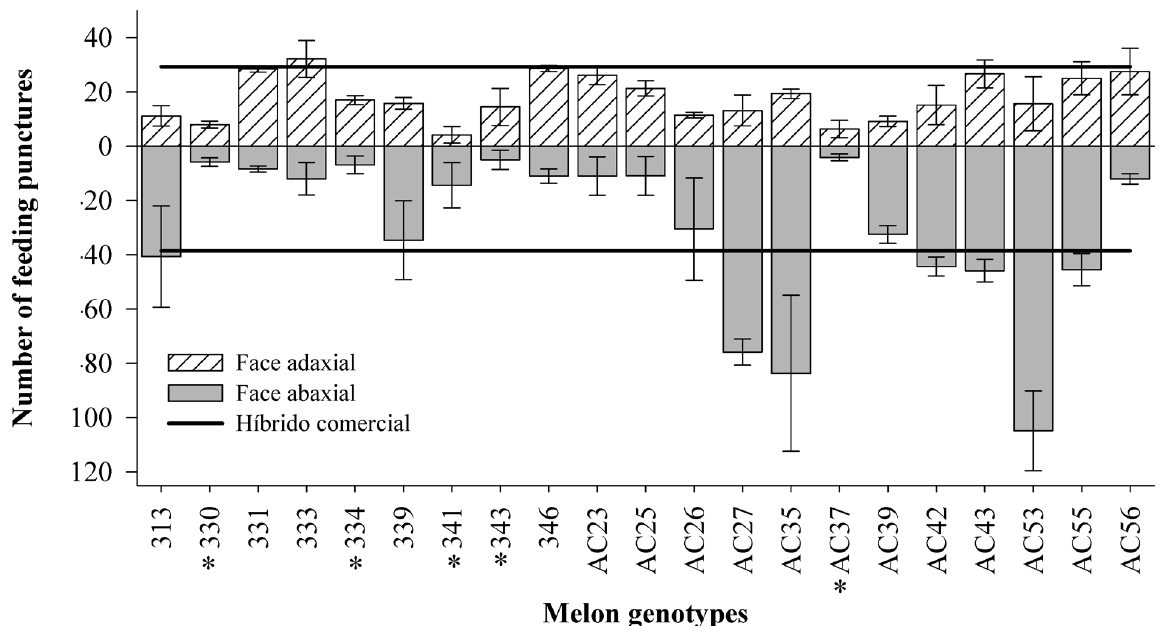
Figure 2. No preference of L. sativae for feeding in melon genotypes. Genotypes followed by an asterisk indicates a significant difference in relation to the commercial hybrid by Dunnett’s test (α = 0.05). Line in bold (mean feeding punctures in the leaves of the susceptible standard genotype), Bars (mean feeding punctures in the abaxial and adaxial sides of the leaves of genotypes with standard